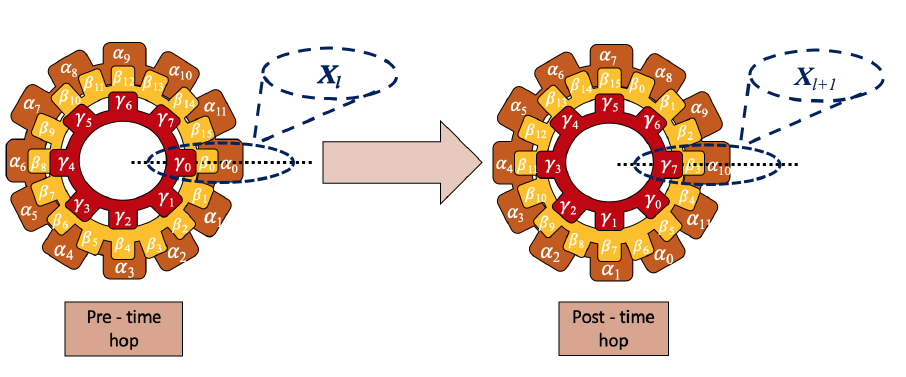
Figure 15. An example of time hopping, where α , β , and γ represent the original counterclockwise orderings α 1 , α 2 , . . . α 9 , etc. The original permutations are not modified during a time hop, but each permutation is essentially rotated, as shown by the